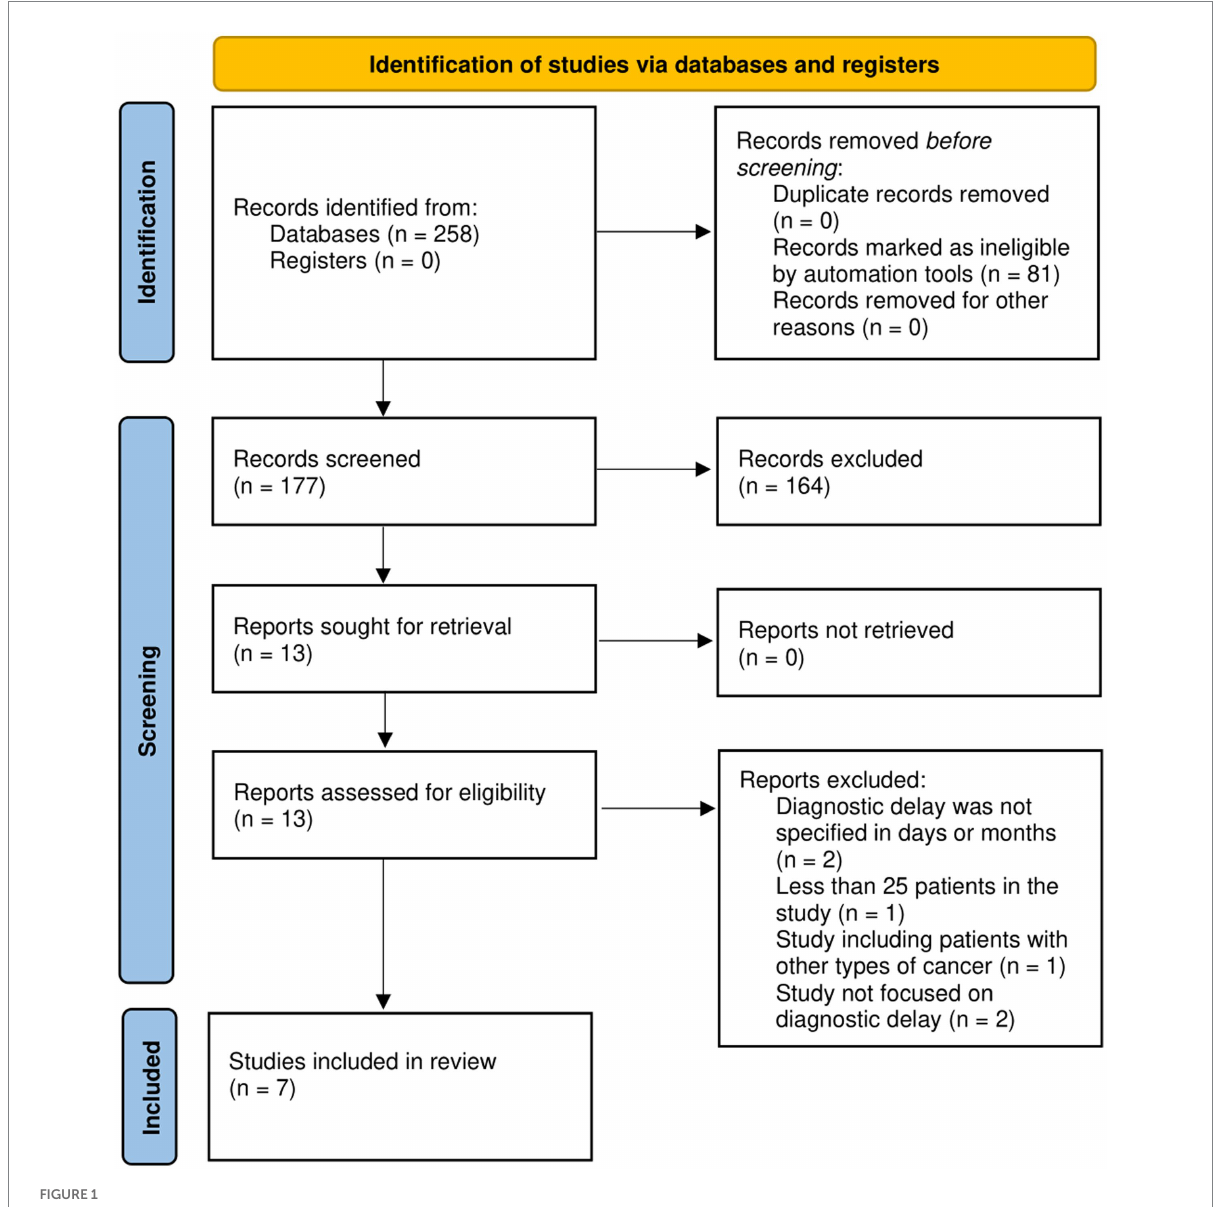
FIGURE 1 PRISMA flow diagram for systematic